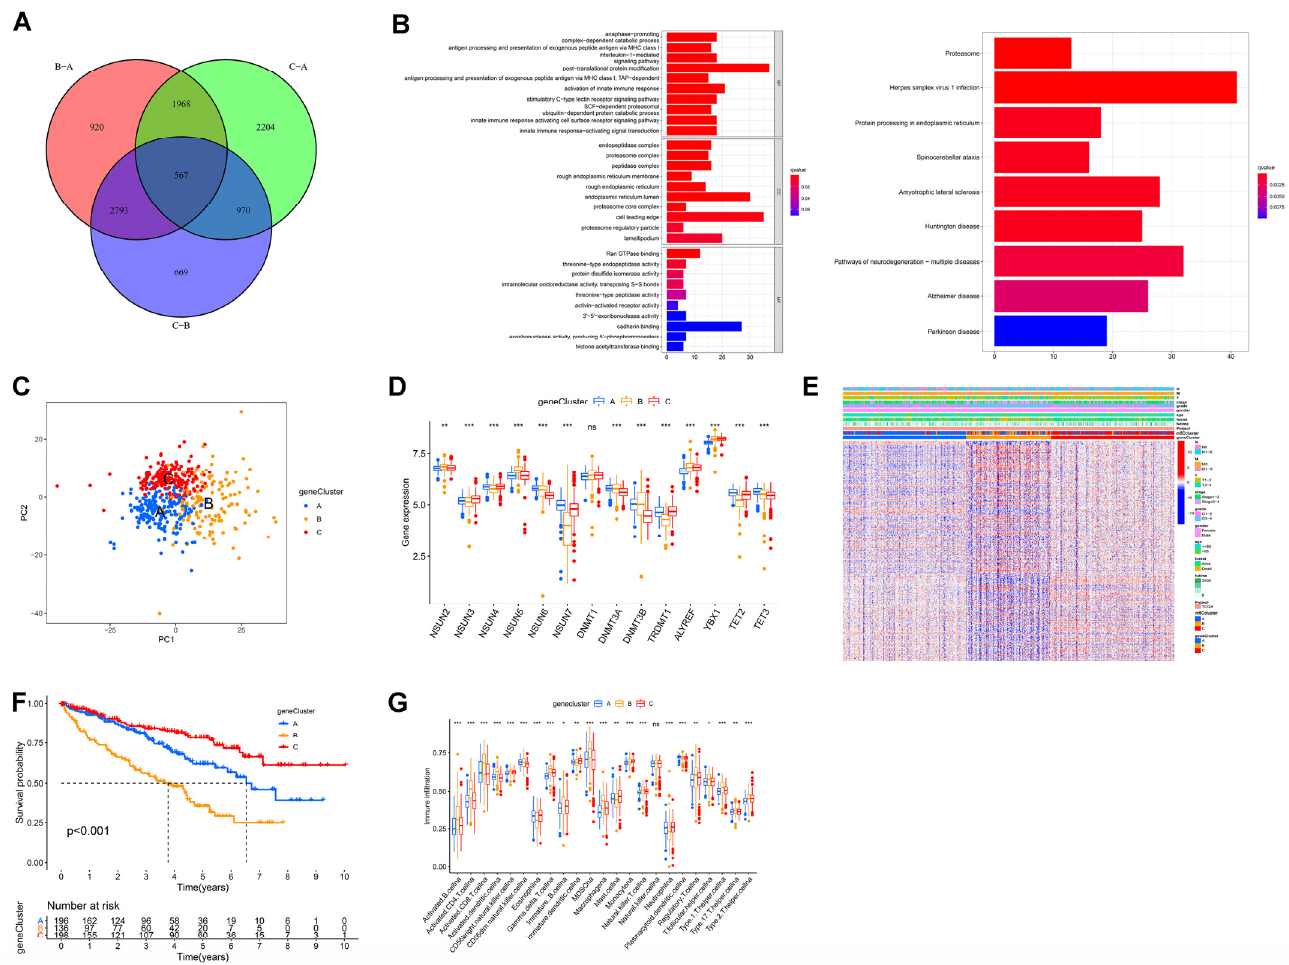
Figure 4. m5C gene clusters and corresponding biological features in ccRCC: ( A ) 567 m5C phenotype-related DEGs shown in Venn diagram; ( B ) Gene Ontology (GO, left) and Kyoto Encyclopedia of Genes and Genomes (KEGG, right) enrichment analyses of 567 DEGs. ( C ) PCA for transcriptome profiles of three m5C gene clusters. ( D ) Differences in expression of 14 m5C regulators in three m5C gene clusters. ( E ) Unsupervised clustering of overlapping m5C phenotype-related genes in TCGA to classify patients into different gene clusters, called m5C gene cluster A–C. ( F ) Kaplan–Meier overall survival (OS) curves for patients in three gene clusters. ( G ) Abundance of each TME-infiltrating cell in three m5C gene clusters. Adjusted p -values are shown as: ns, not significant; * p < 0.05; ** p < 0.01; *** p < 0.001; ns is not significant.